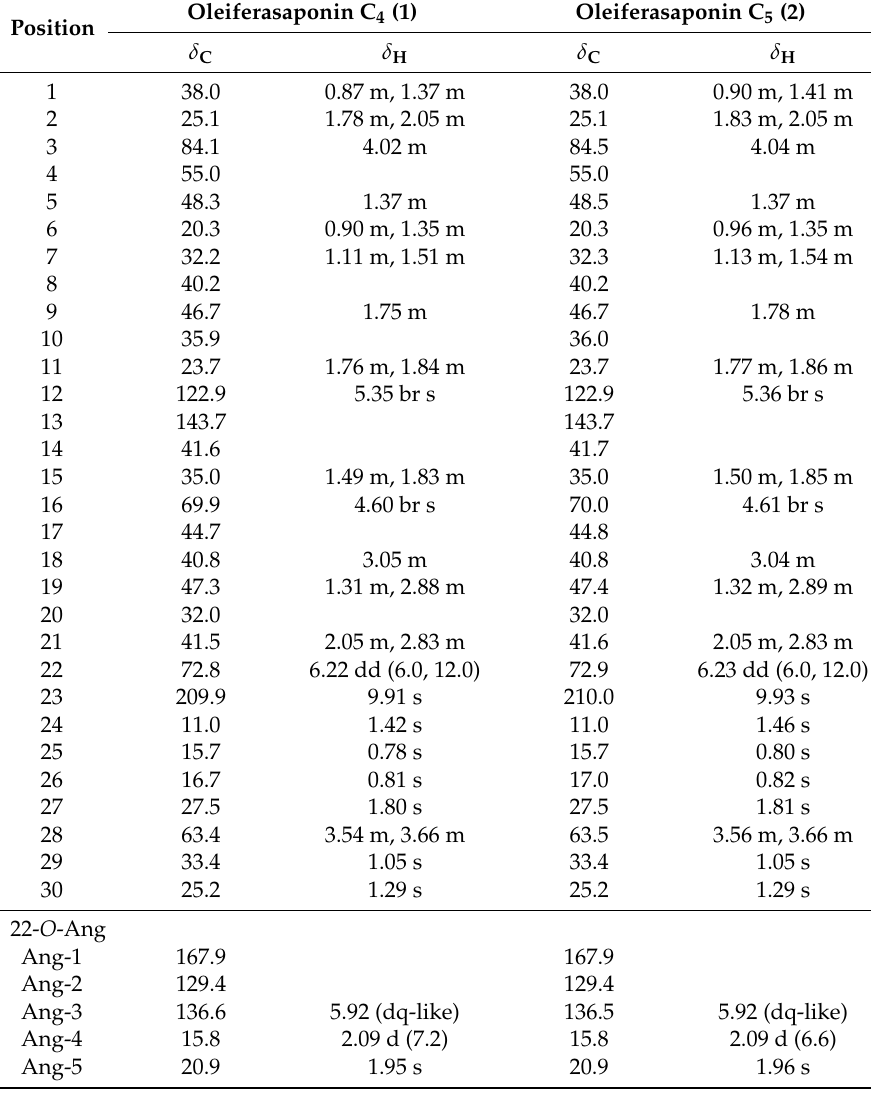
Table 1. 1 H- and 13 C-NMR spectroscopic data of oleiferasaponins C 4 and C 5 in C 5 D 5